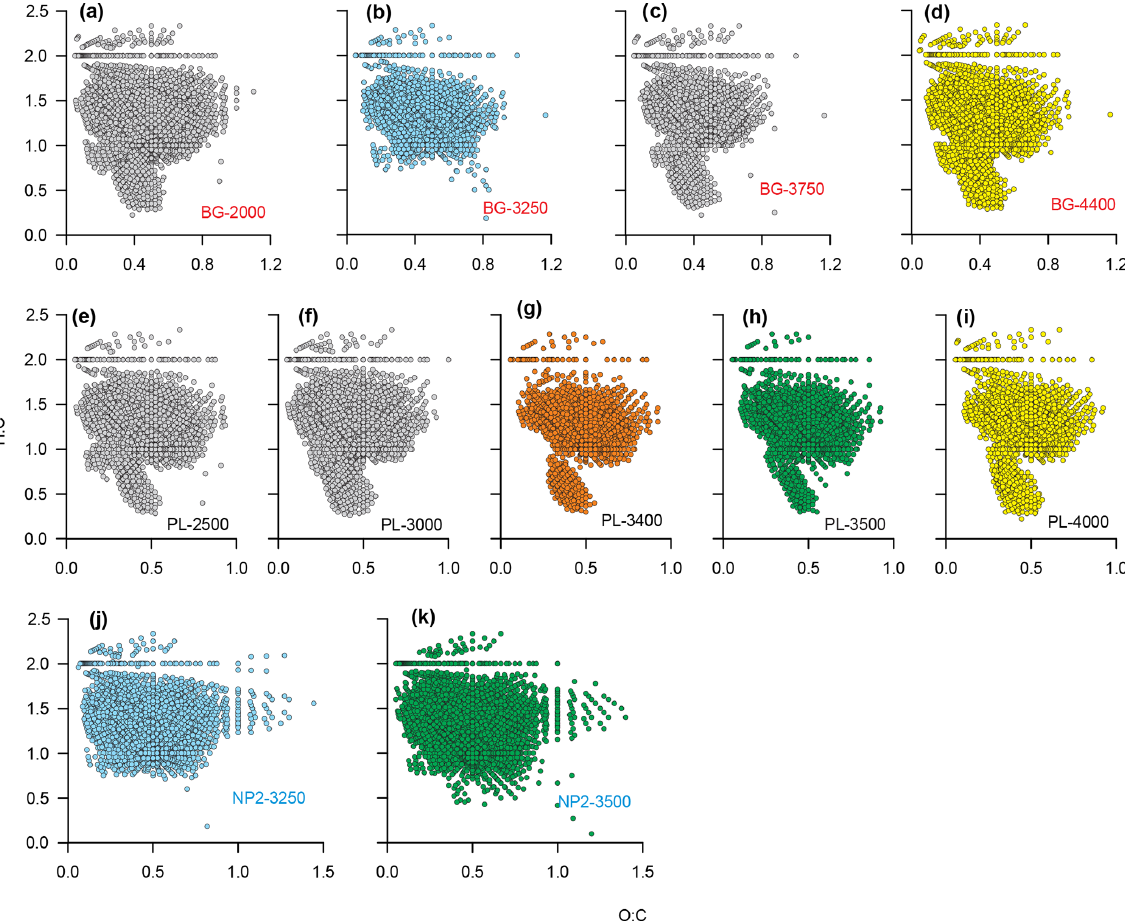
Figure 8. Dissolved organic matter (DOM) formulas on van Krevelen diagrams showing O : C and H : C ratios of the formulas at stations (a–d) BG, (e–i) PL and (j–k) NP2. Sample names are coded as station name and sample depth. Orange color is given to PL-3400, where the plume effect is expected to be the highest. Blue and green are used for the formulas in samples that were taken from same depths at different stations. Yellow color is for the samples that were taken from the bottom of the water column at BG and